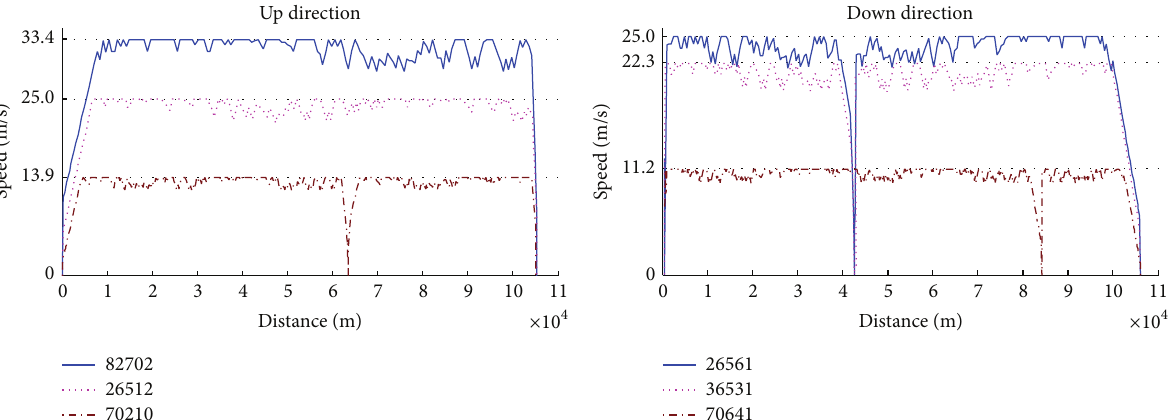
Figure 14: Train speed-distance curve (NCBS number: 4).